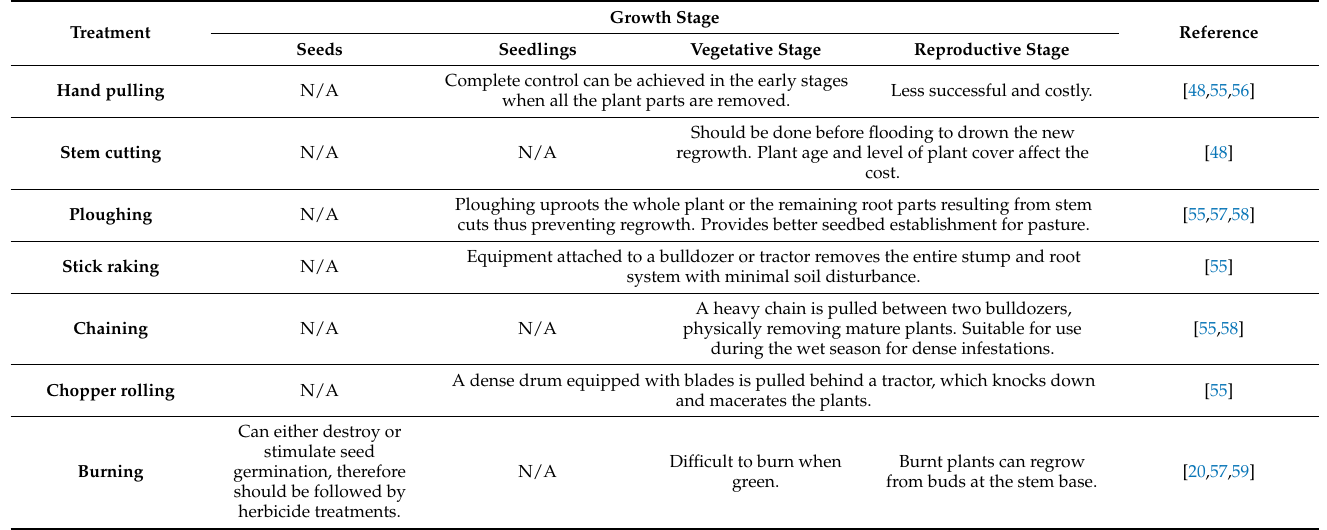
Table 2. Commonly used physical control measures implemented at different growth stages of Mimosa pigra.